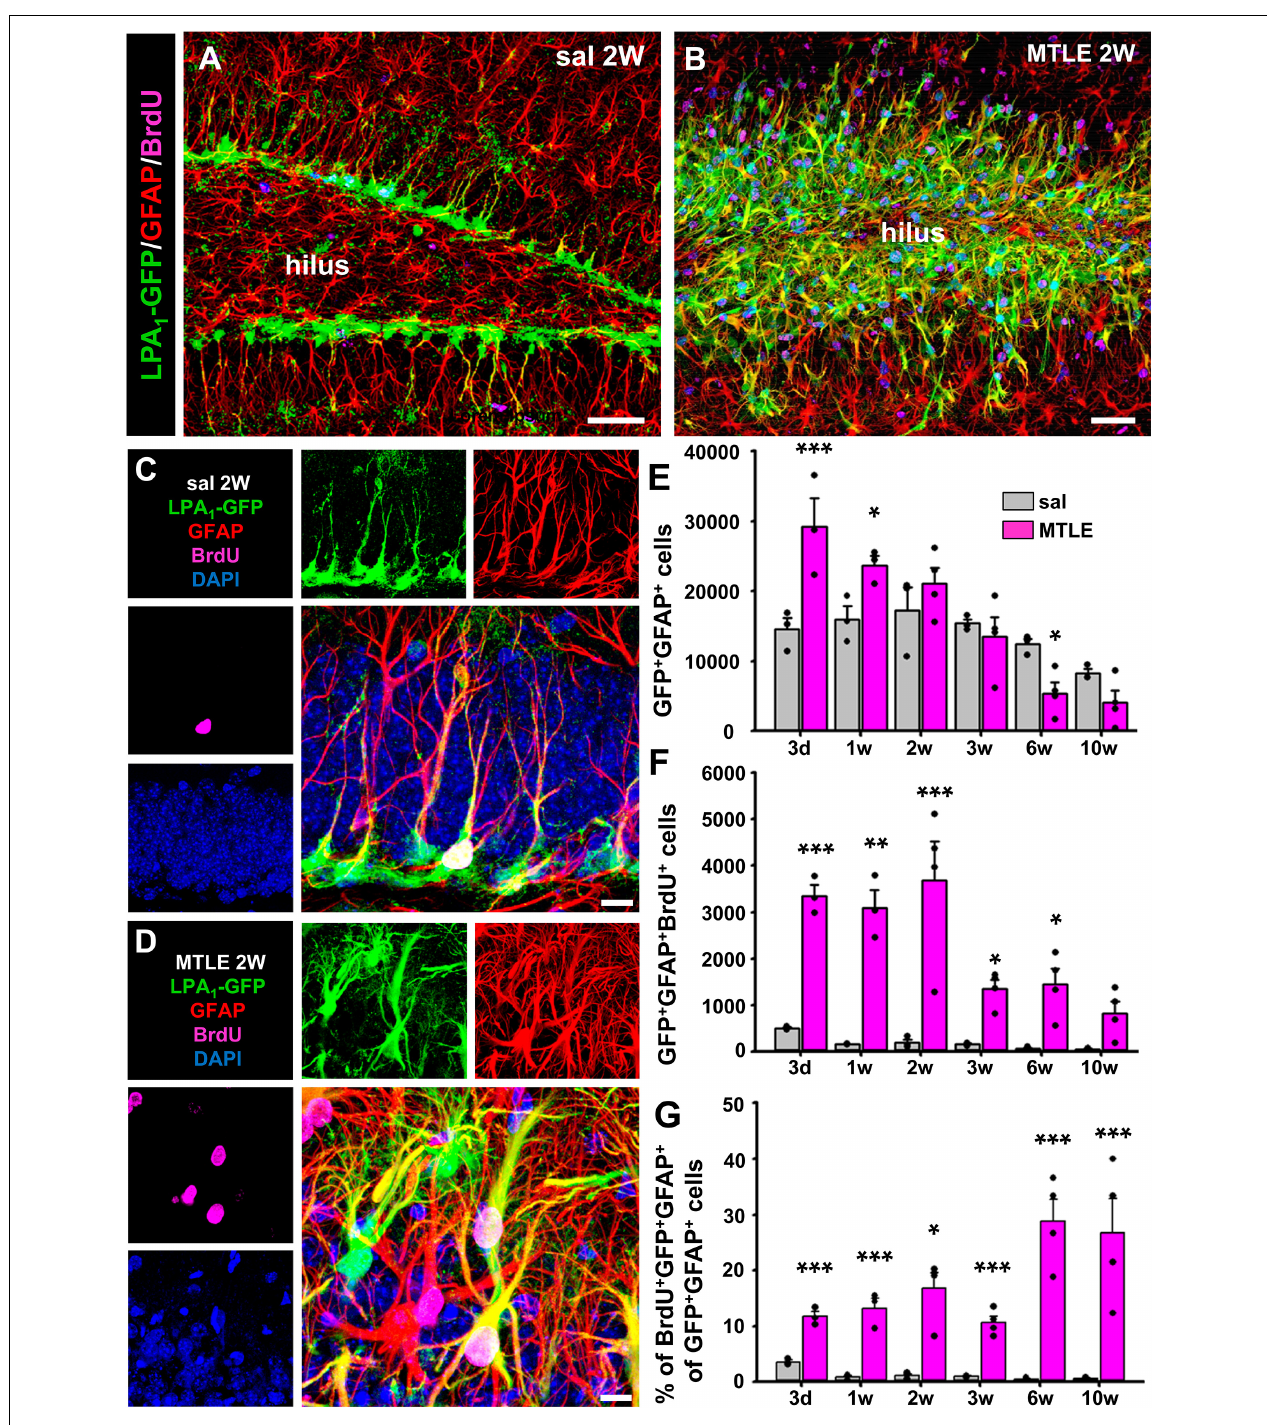
FIGURE 2 | Lysophosphatidic acid receptor 1–GFP expression is maintained in seizure-induced React-NSCs. Control and MTLE mice were administered BrdU (four injections, 2 h apart) on the second day after surgery for the saline/KA intrahippocampal injection and then sacrificed 3 days or 1, 2, 3, 6, or 10 weeks after surgery. Expression of LPA 1 -GFP is restricted to GFAP-expressing NSCs in the SGZ in the control mice (A) and to GFAP-expressing React-NSCs located in the SGZ or GCL in the MTLE mice (B) . In the molecular layer, GFAP-expressing astrocytes did not express LPA 1 -GFP as shown by z-stack projections obtained by confocal microscopy. The time-course analysis with BrdU costaining at higher magnification (C,D) shows an overall increase in the number of LPA 1 -GFP + GFAP + cells in early time points and a later decline (E) . The number of BrdU + LPA 1 -GFP + GFAP + cells is much higher in MTLE mice in every time point, but it decreases in the later ones (F) . The percentage of BrdU + LPA 1 -GFP + GFAP + follows an opposite trend as it increases over time, although it is also much higher than in controls in all time points (G) . Scale bar is 50 µ m in (A,B) and 10 µ m in (C,D) . Data were analyzed by a two-way ANOVA. Post hoc Holm–Sidak was used to analyze differences between time points and sal vs. MTLE. Only the differences between sal vs. MTLE in each time are shown. * p < 0.05, ** p ≤ 0.005, *** p ≤ 0.001.